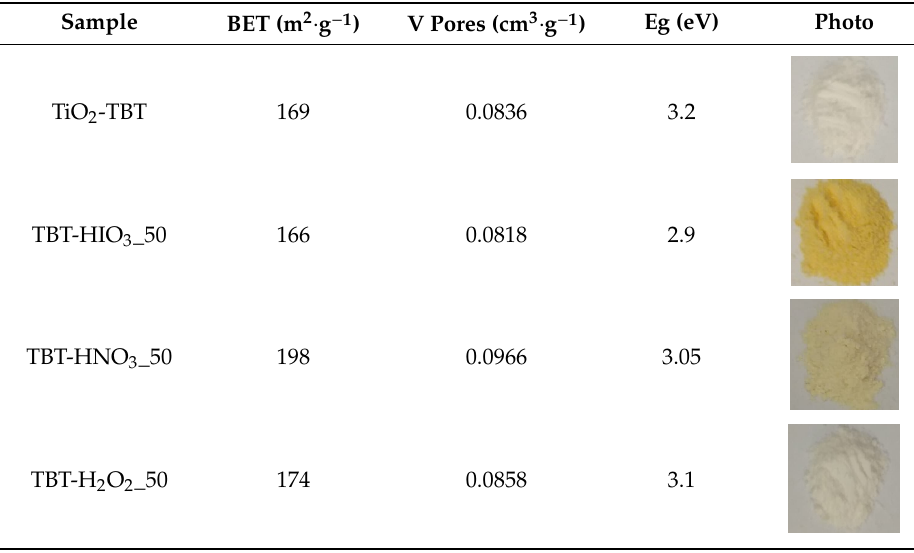
Table 2. Physicochemical characteristic of the obtained defective TiO 2 samples.